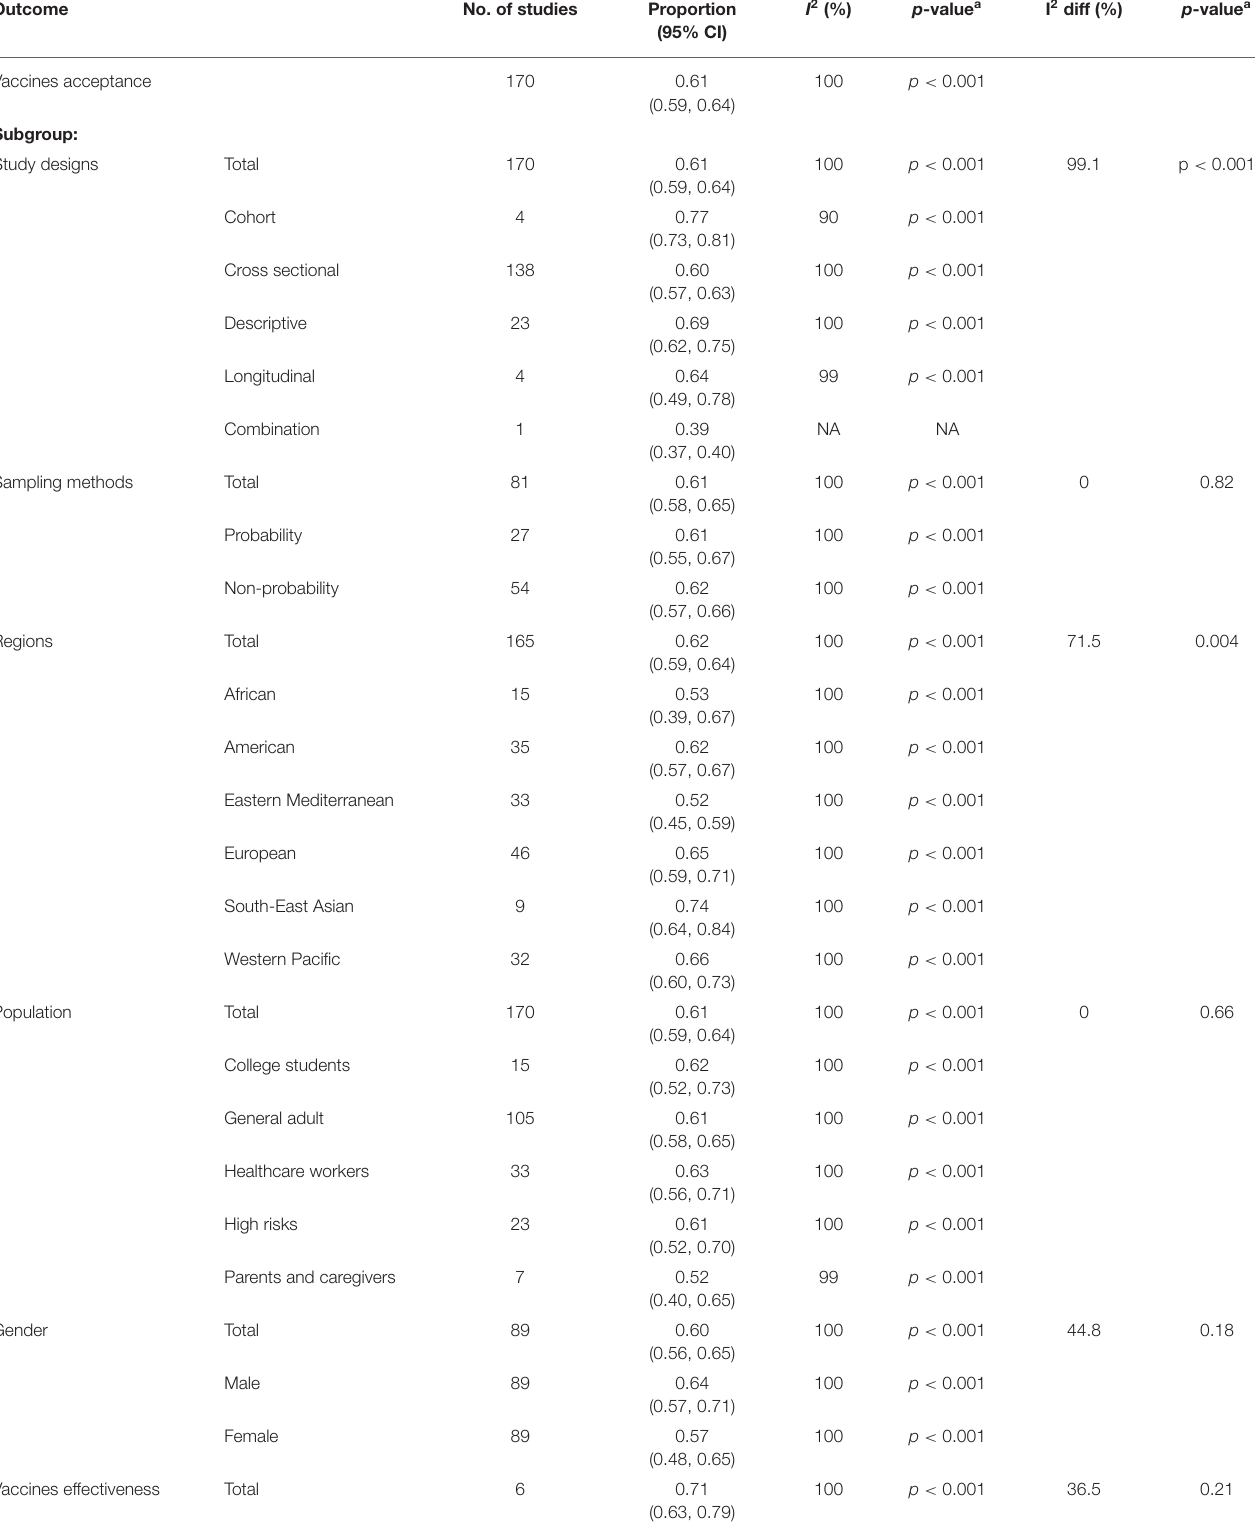
TABLE 1 | The outcome measures of COVID-19 vaccines acceptance. Outcome